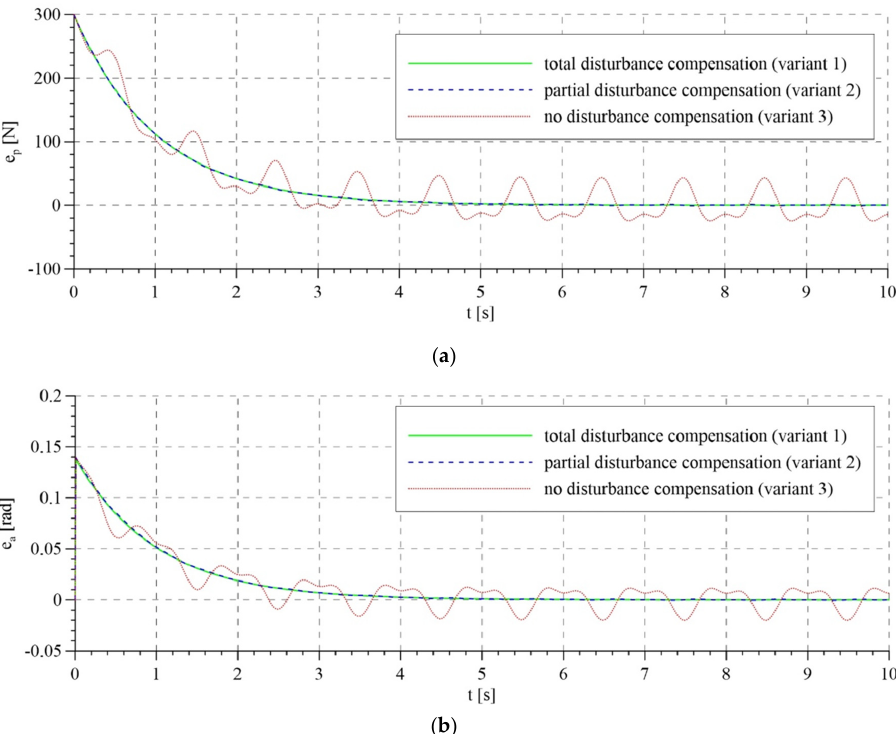
Figure 8. Tracking errors for the control system based on the mathematical model: ( a ) tracking error of the passive part of the system—force error; ( b ) tracking error or the active part of the system—rotation angle error.